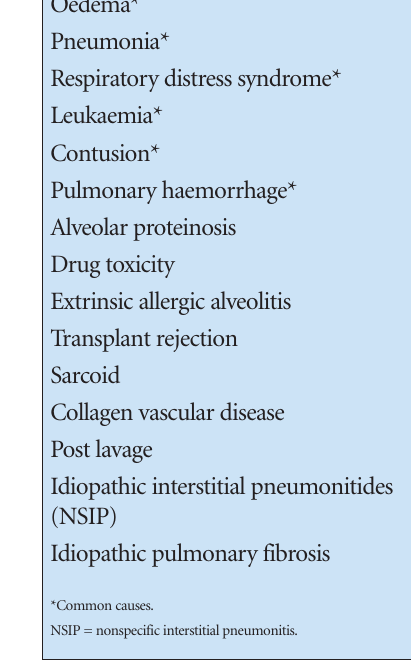
Fig. 5. Lobar airspace